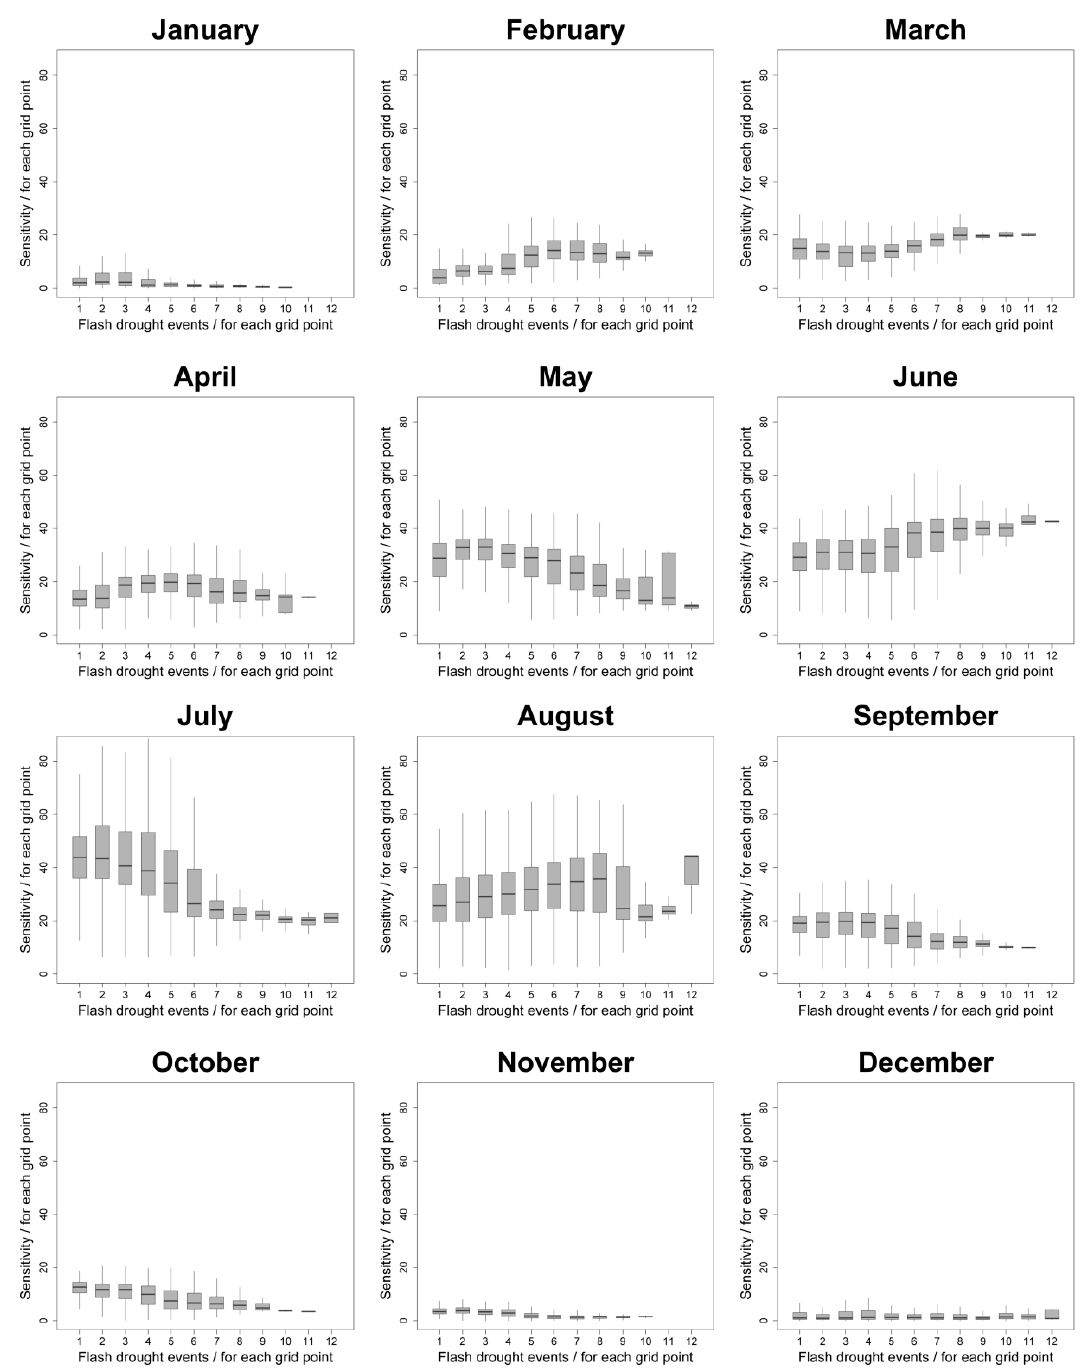
Figure 9. Monthly frequency of flash drought events/for each grid point obtained from the SPEI and its sensitivity (%) to AED on mainland Spain and the Balearic Islands in each month over the period 1961–2018 at a short time scale (1-month). Frequencies of flash drought events with a residual number of cases are not represented.